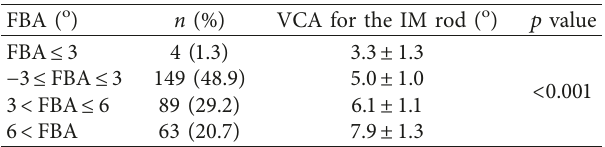
Table 4: Categorisation of the VCA for the IM rod according to the FBA. FBA ( o ) n (%) VCA for the IM rod ( o